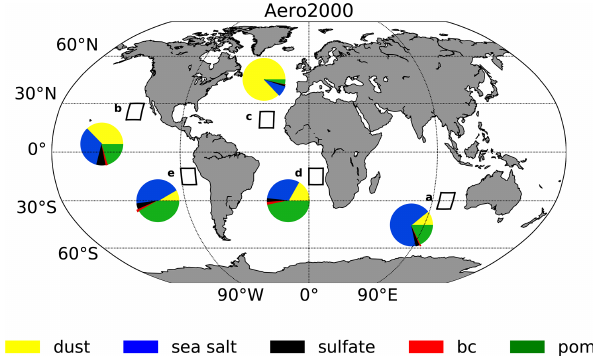
Figure 1. The relative columnar burden contribution of each aerosol type to the total column burden in the control simulation in five regions of marine stratocumulus clouds. The boxes indicate the five regions of stratocumulus clouds – a: Australian, b: Californian, c: Canarian, d: Namibian, e: